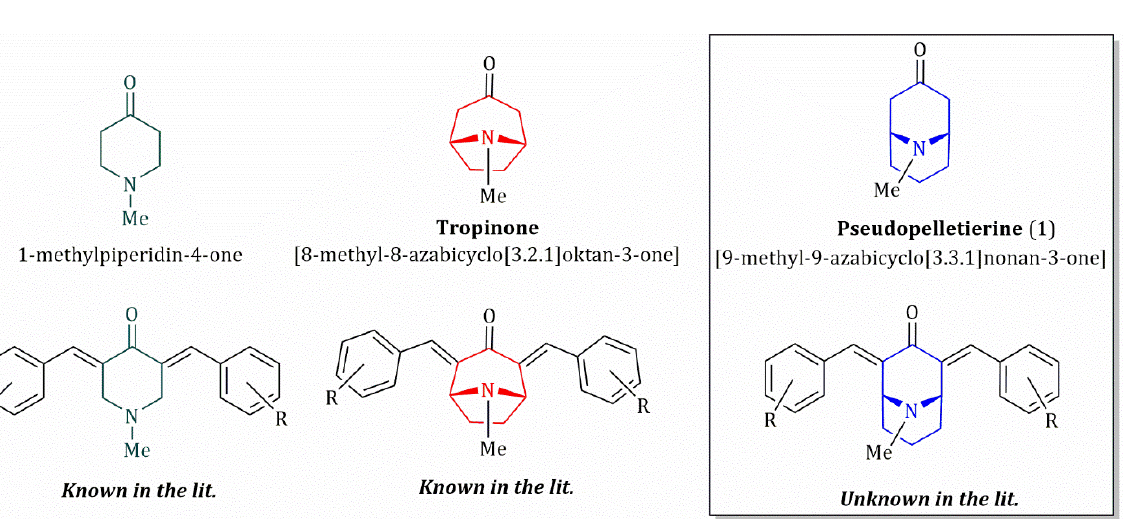
Scheme 2. Monocarbonyl analogs of CUR containing the heterocyclic scaffold.